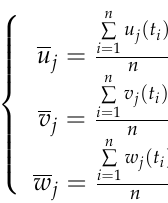
Figure 9. Modal shapes of spherical inflatable membrane structures: ( a ) 1st and 2nd horizontal modes (without cable); ( b ) 3rd vertical mode (without cable); ( c ) 1st and 2nd horizontal modes (cross cable); ( d ) 3rd vertical mode (cross cable); ( e ) 1st and 2nd horizontal modes (radial cable); ( f ) 3rd mode vertical (radial cable).